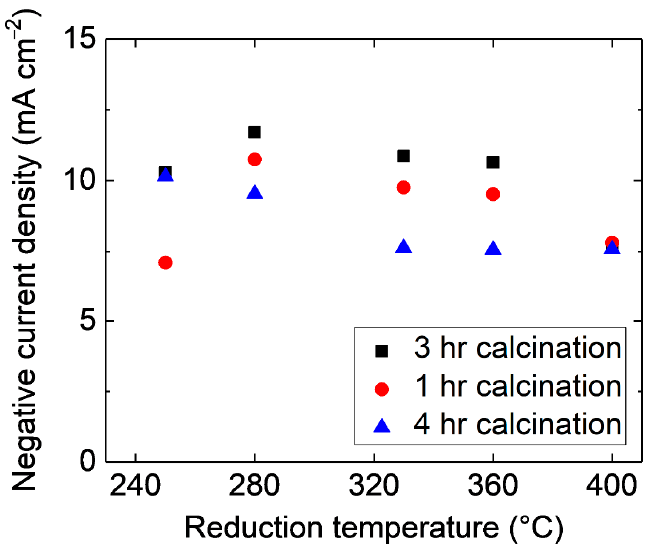
Figure A7. Total current densities of the copper hollow fibers as a function of temperature of treatment in H 2 . The hollow fibers were calcined at 600 °C for 1, 3, and 4 h (see legend in the Figure), respectively, prior to reduction in the hydrogen flow. The graphs shows that the fibers prepared by reduction in hydrogen at 280 °C show the highest current densities, in particular for the fibers prepared by calcination for 1 h or 3 h. It should also be noted that the order in performance (3 h > 1 h > 4 h) of each of the 4 fibers prepared at different calcination times is consistent throughout the temperature range of reduction.